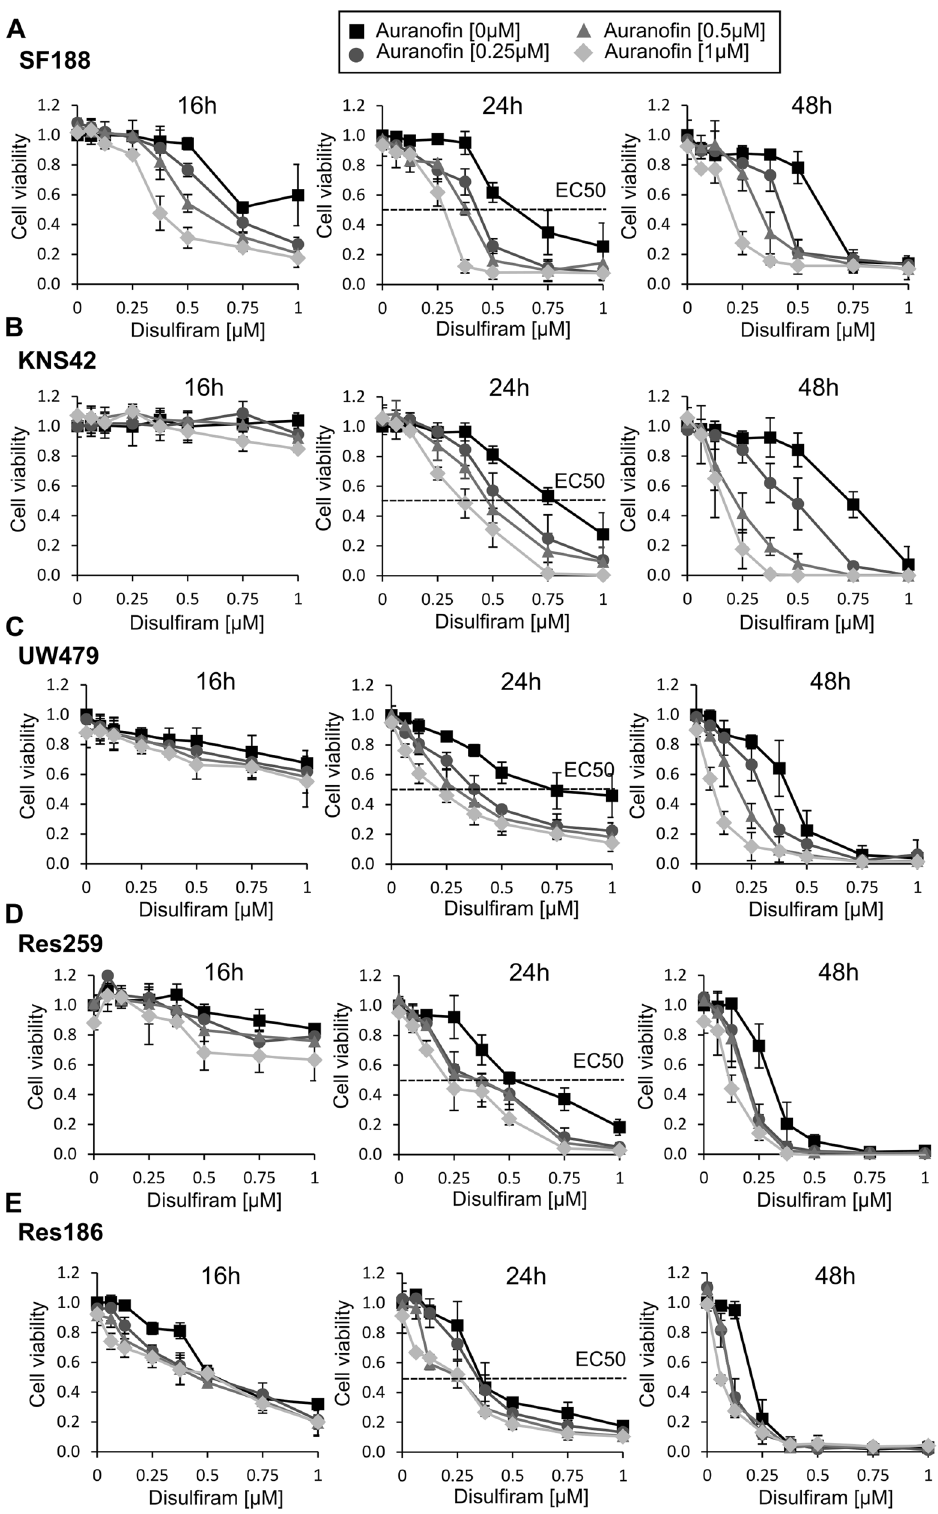
Fig. 3 Disul fi ram and aurano fi n synergistically inhibit cell proliferation. A – E Cells were plated in 96-wells plates. The following day cells were treated with the indicated concentrations of disul fi ram in the absence or presence of increasing doses of aurano fi n. At the indicated time cell viability assays were performed. Data are mean ± STD; n =